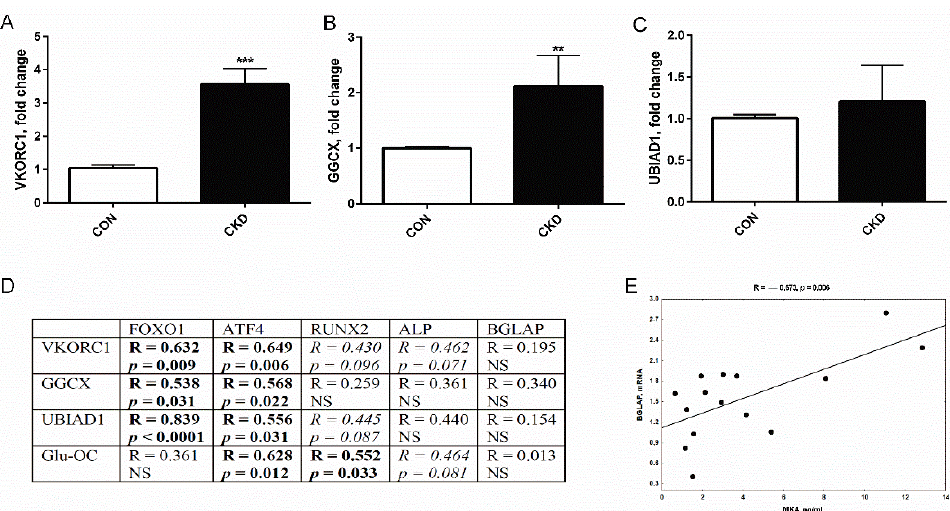
Figure 6. The expression of genes of vitamin K cycle enzymes in femurs of rats with chronic kidney disease (CKD) ( A – C ), and their associations with the expression of genes of osteoblastogenesis and trabecular Glu-OC levels ( D ), as well as the relationship between serum MK4 level and BGLAP expression in bone of rats with CKD ( E ). ** p < 0.01, *** p < 0.001 CON versus CKD rats; CON— controls; VKORC1—vitamin K epoxide reductase complex subunit 1; GGCX—the gamma ‐ glutamyl